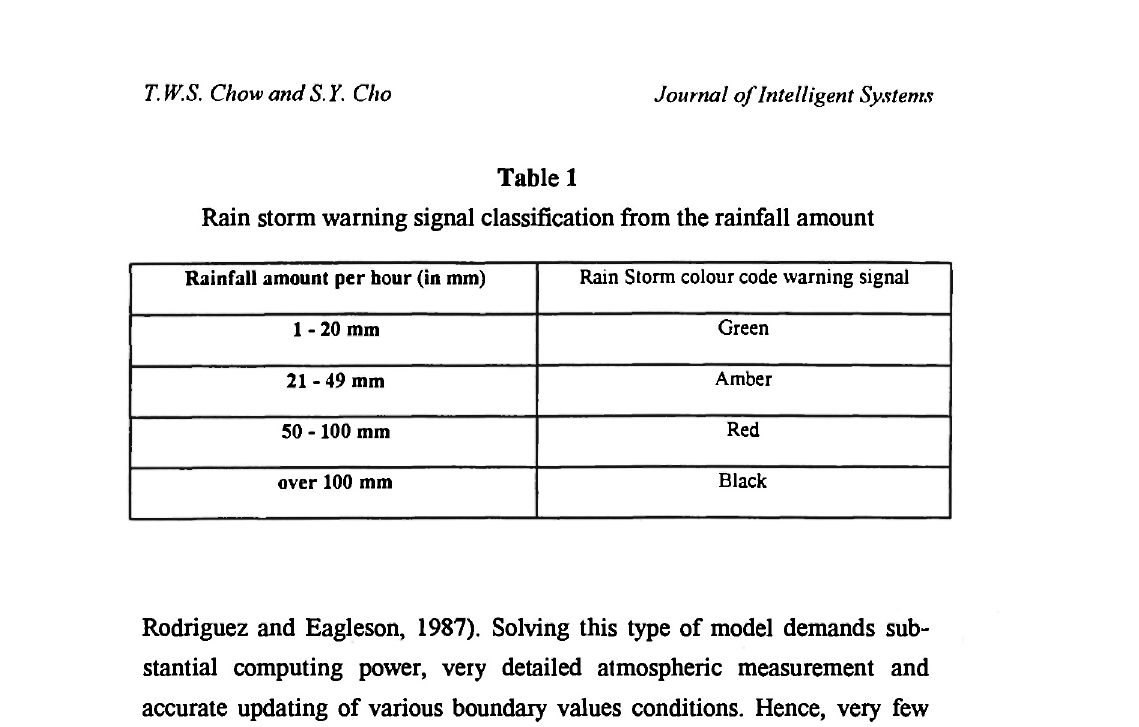
Rain storm warning signal classification from the rainfall amount Rainfall amount per hour (in mm) Rain Storm colour code warning